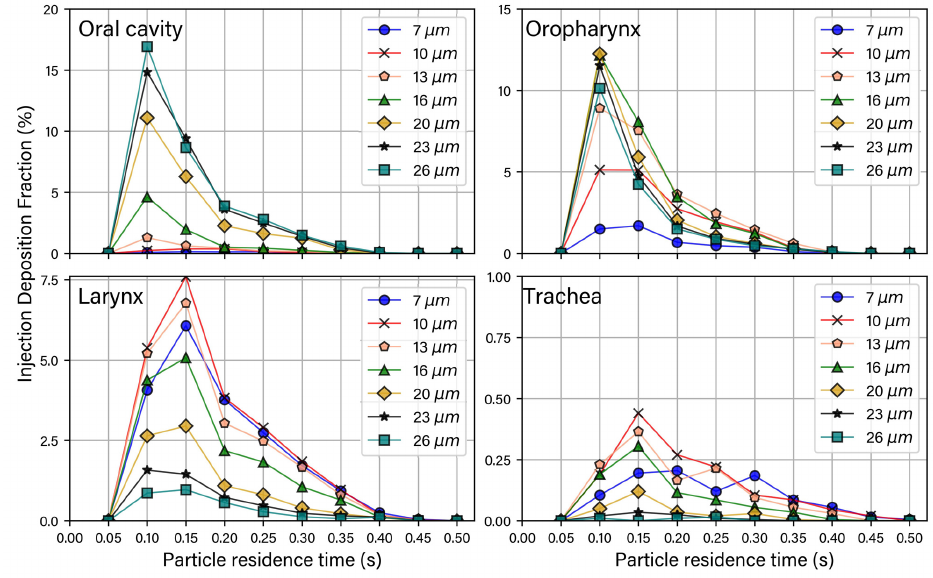
Figure 6. Deposition fraction for each injection at different time intervals (time intervals = 0.5